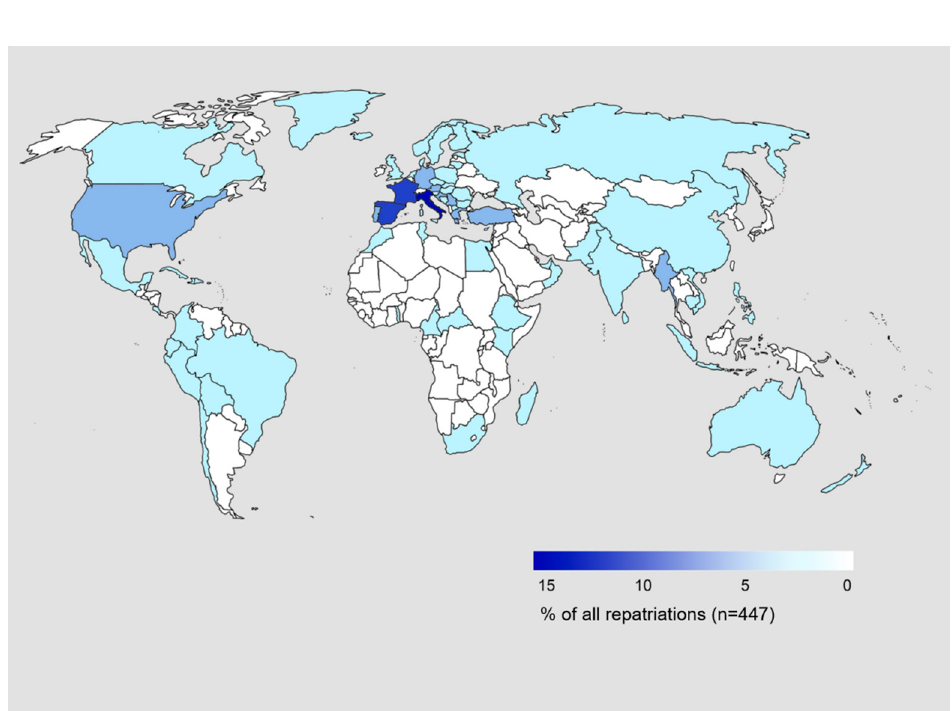
Table 2. Numbers and percentages of top 5 countries.